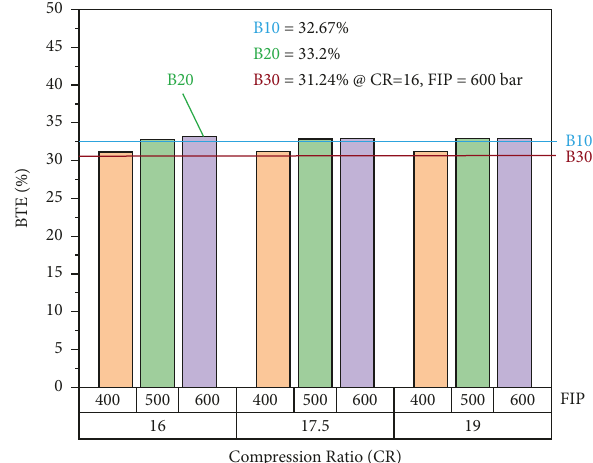
Figure 6: BTE for B20 blend at various FIP and CR.